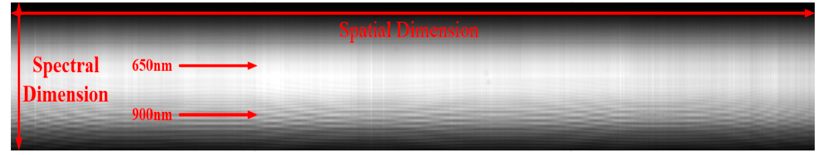
Figure 2. The calibration data acquired from Camera 1.